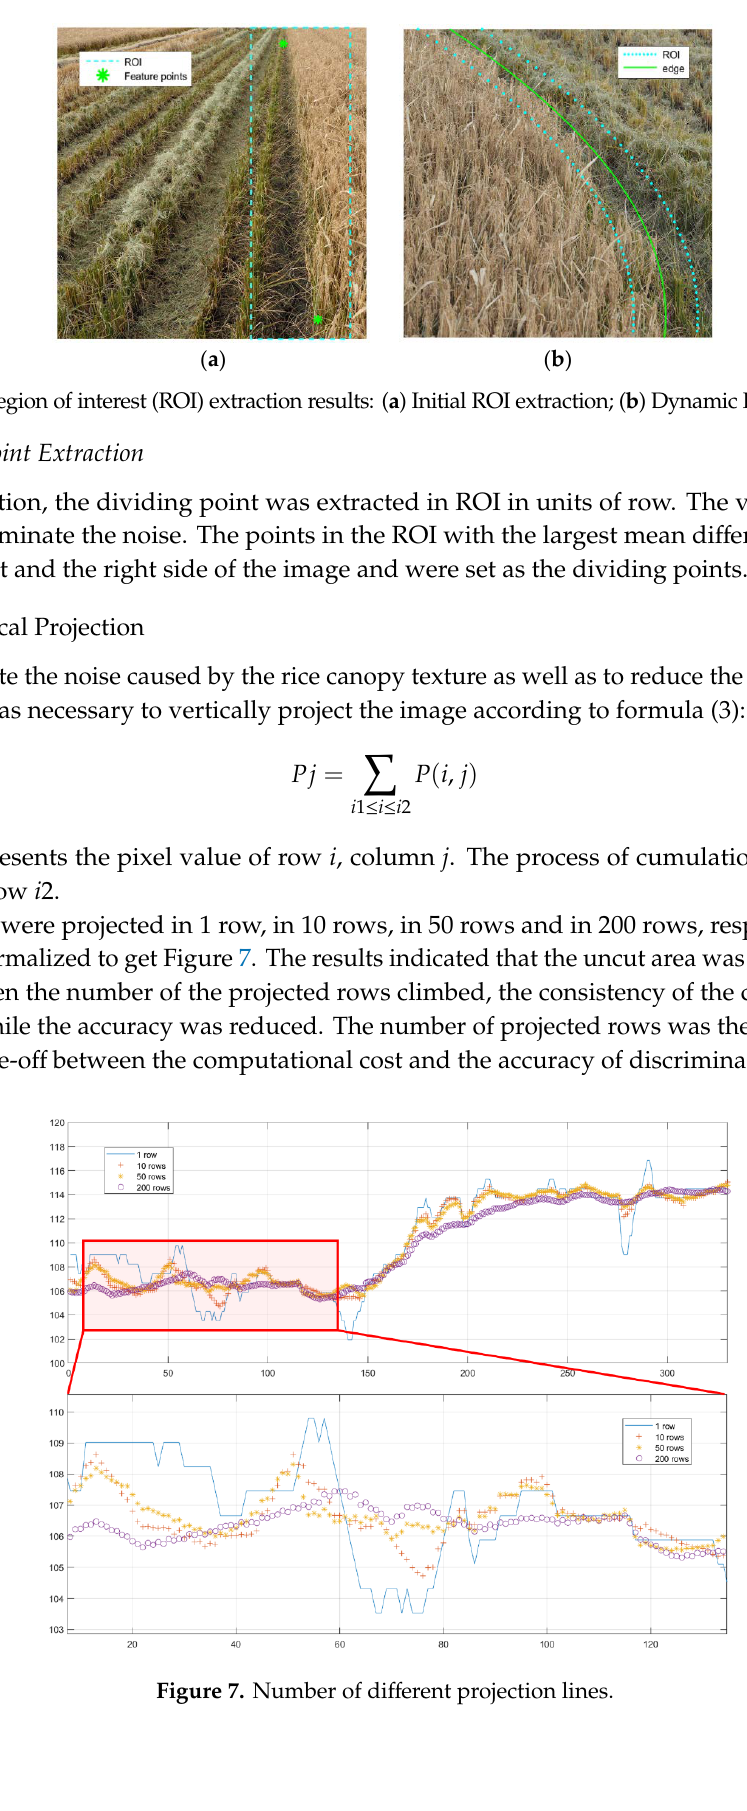
Figure 7. Number of different projection lines.